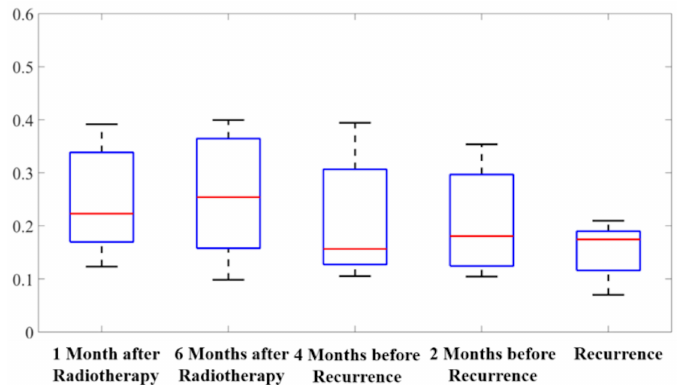
Figure 4. Box plots of the mean values of fractional anisotropy (FA) within recurrent tumor regions over the five time points for selected 9 patients. The five bars in the box plots indicate, from bottom to top, the minimum, first quartile, median, third quartile, and the maximum.